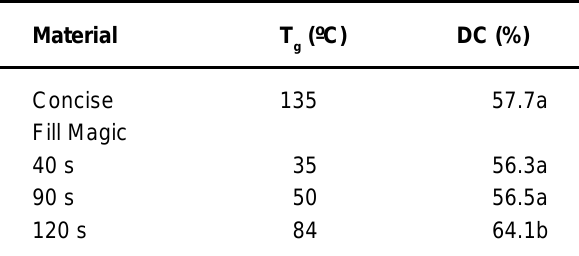
TABLE 2- Glass transition temperature (T conversion (DC) of the orthodontic composites evaluated in the study